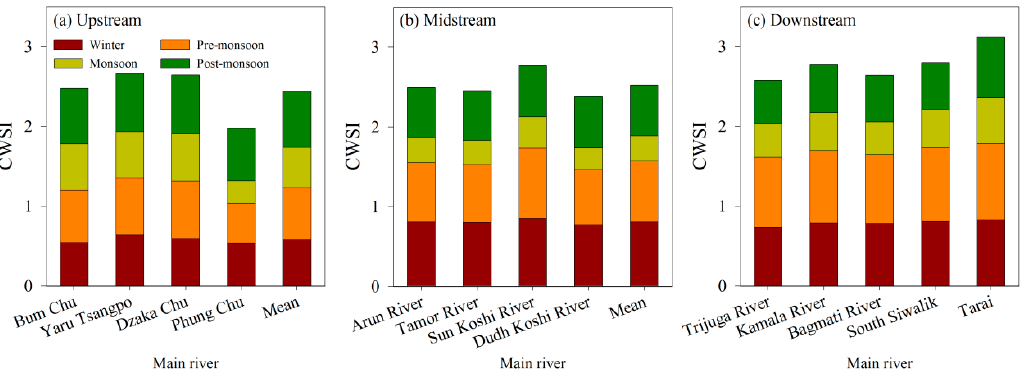
Figure 5. Distribution of Drought degree from different monsoon stages in Koshi River Basin (KRB).